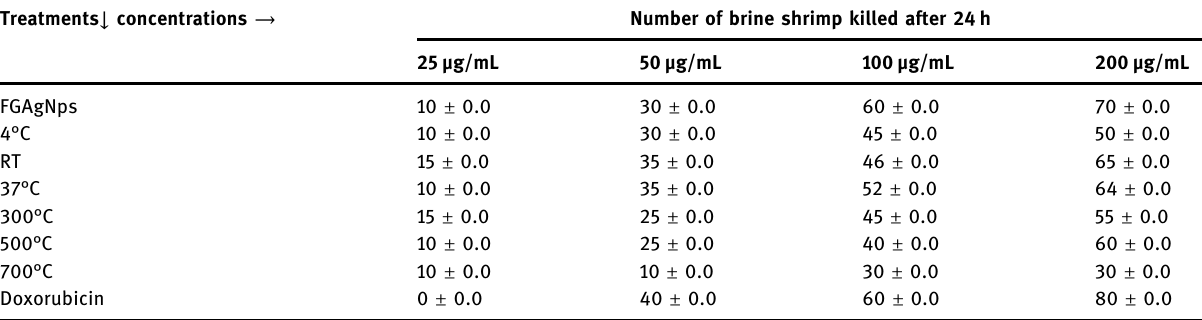
Table 4: Brine shrimp toxicity assay of green - synthesized silver nanoparticles ( GAgNPs ) and the extract of Allium sativum ( Gaqu ) . Treatments ↓ concentrations → Number of brine shrimp killed after 24